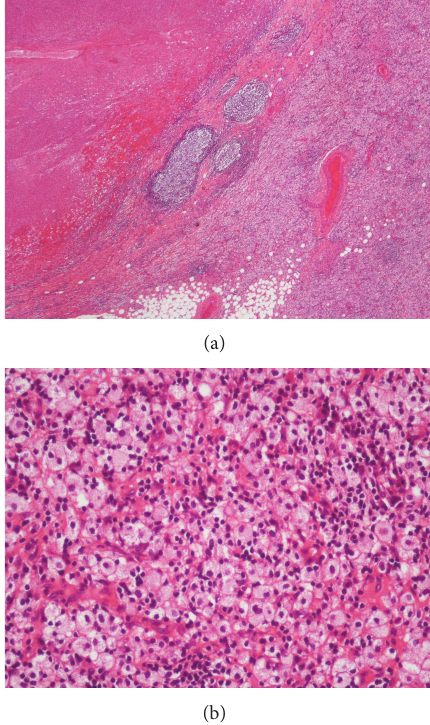
Figure 2: (a) Small lymphoid follicles at the edge of a necrotic area. (b) Sheets of foamy histiocytes mixed with small lymphoid cells found outside the necrotic